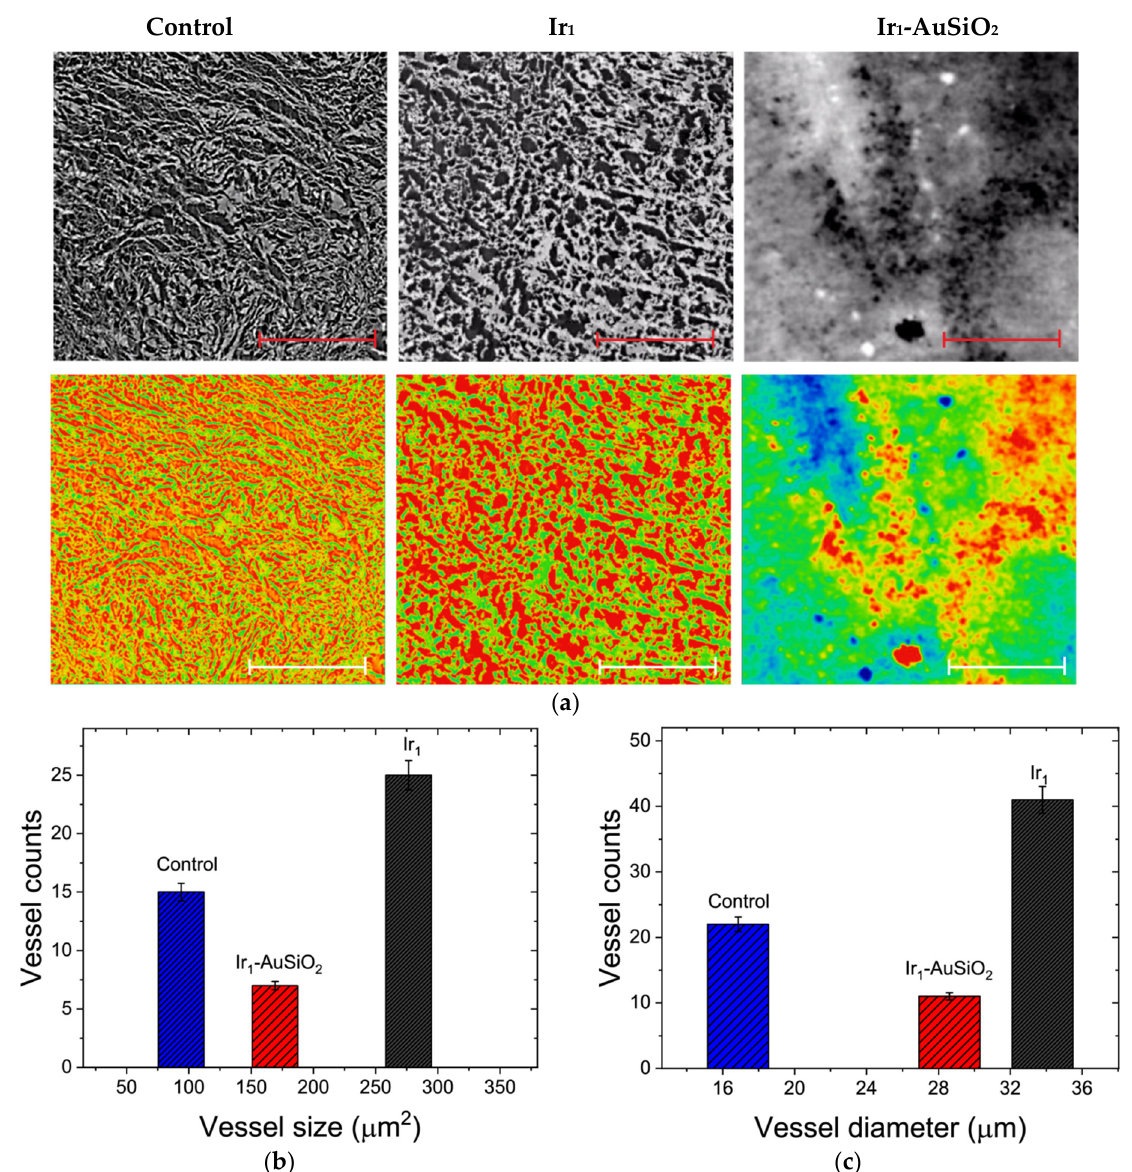
Figure 5. X-ray phase-contrast tomography images and quantitative analysis of the vascular network of ex vivo GBM samples. ( a ) Grayscale (top) tomography images of GBM samples treated (from left to right) only with the radiation dose (control), or after intratumoral injection of Ir 1 or Ir 1 -AuSiO 2 followed by light exposure. At the bottom, the same images are reported by using different colors for better visualization (red: blood vessels; green: GBM cells; blue: Ir 1 -AuSiO 2 clusters). Scale bar: 300 µ m; box: 800 × 800 pixels. ( b ) Average distribution of vessels at different sizes and ( c ) diameter range in GBM samples treated only with the radiation dose (control) or after intratumoral injection of Ir 1 or Ir 1 -AuSiO 2 followed by light exposure. Quantitative analysis was performed on a working area of 400 × 400